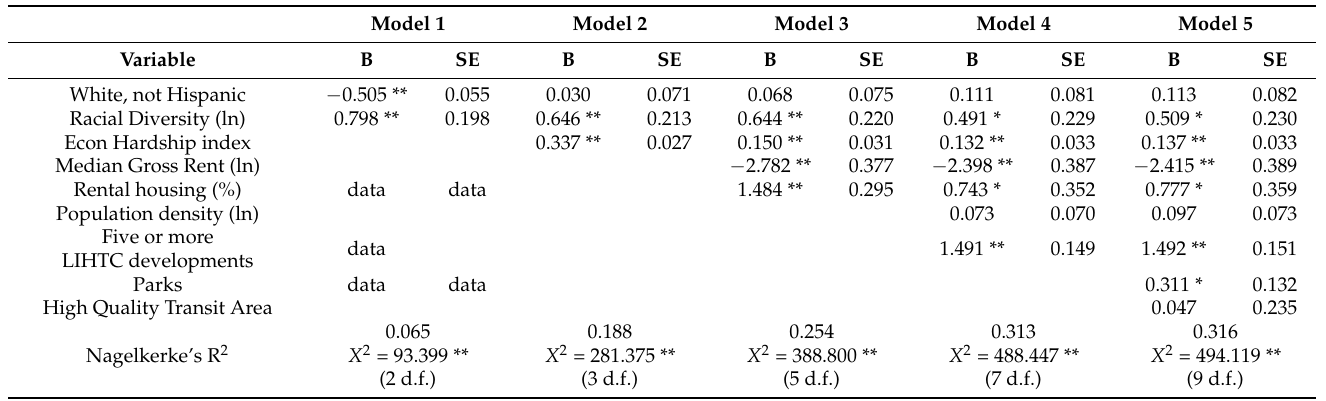
Table 7. Logistic Regression Results for Los Angeles